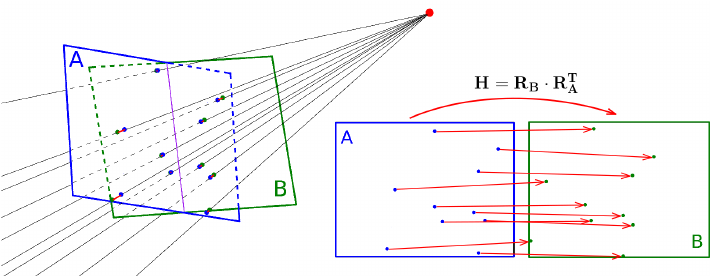
Figure 2. Homography between the undistorted coordinates in two different images “A” and “B”.